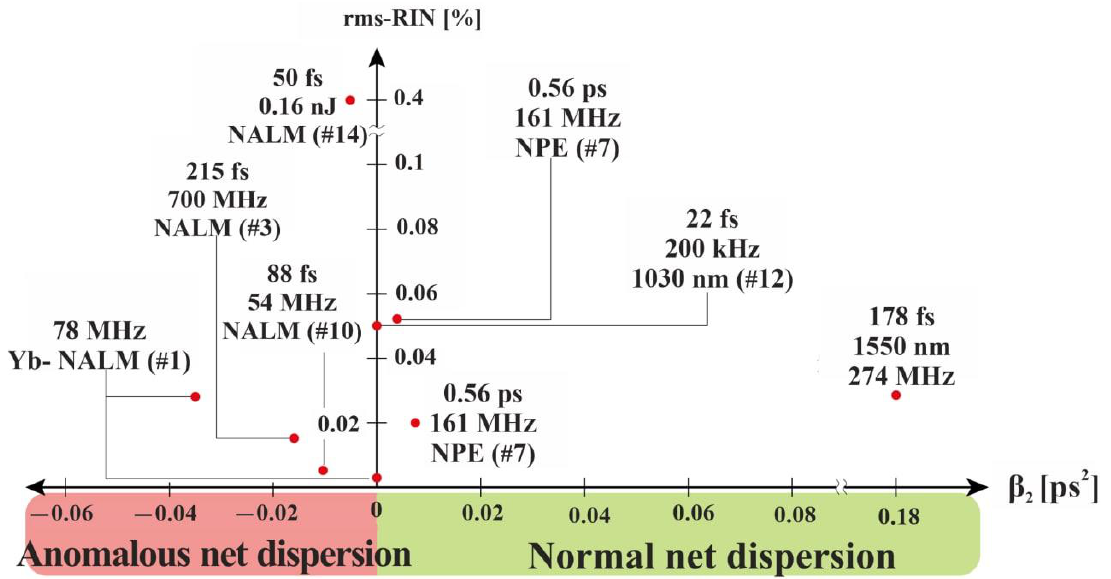
Figure 1. Summary of the rms-RIN performance of passively mode-locked fiber lasers with various net dispersion values.